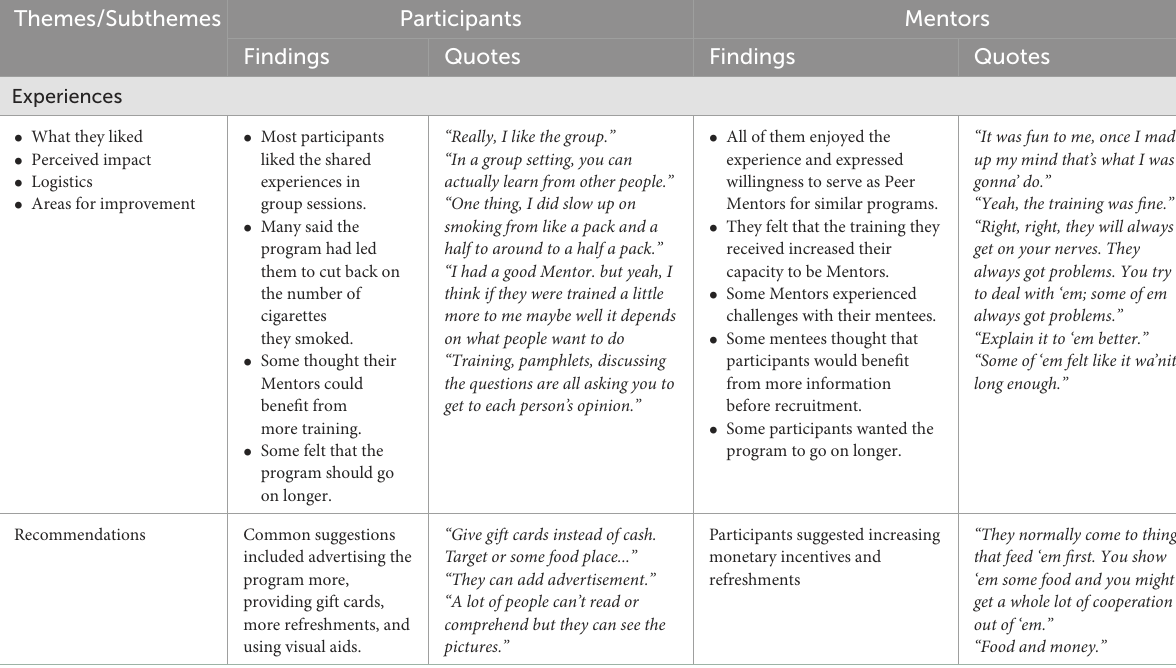
TABLE 7 Qualitative findings from public housing peer mentoring